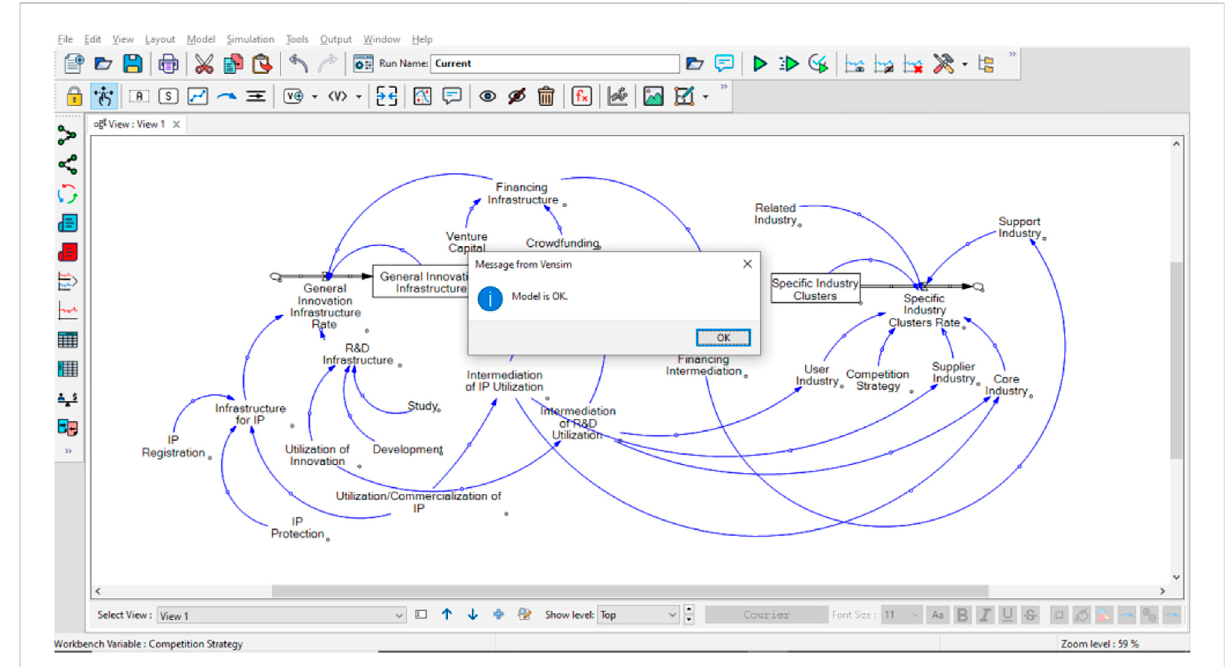
FIGURE 5 The model was running well without errors in the formulation source: Data Processing,